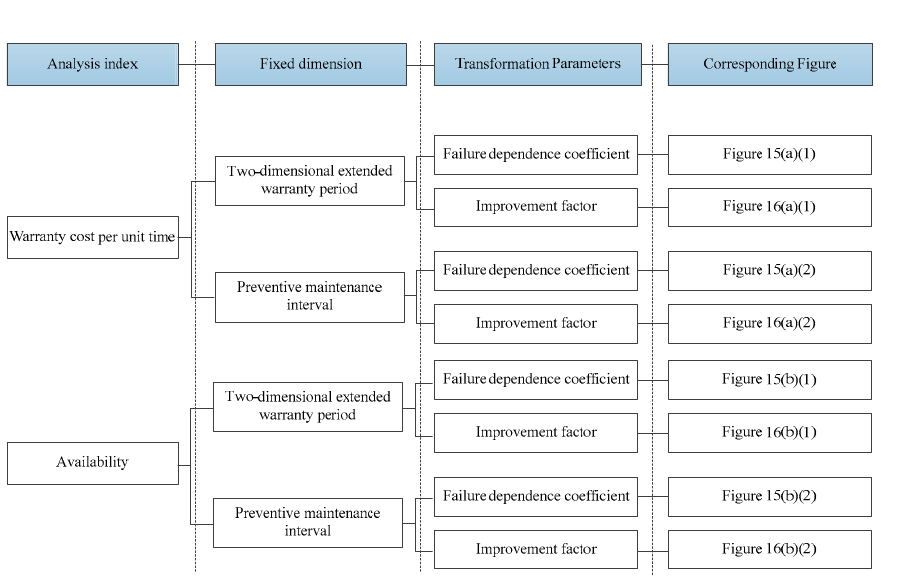
Figure 14. Sensitivity analysis framework.